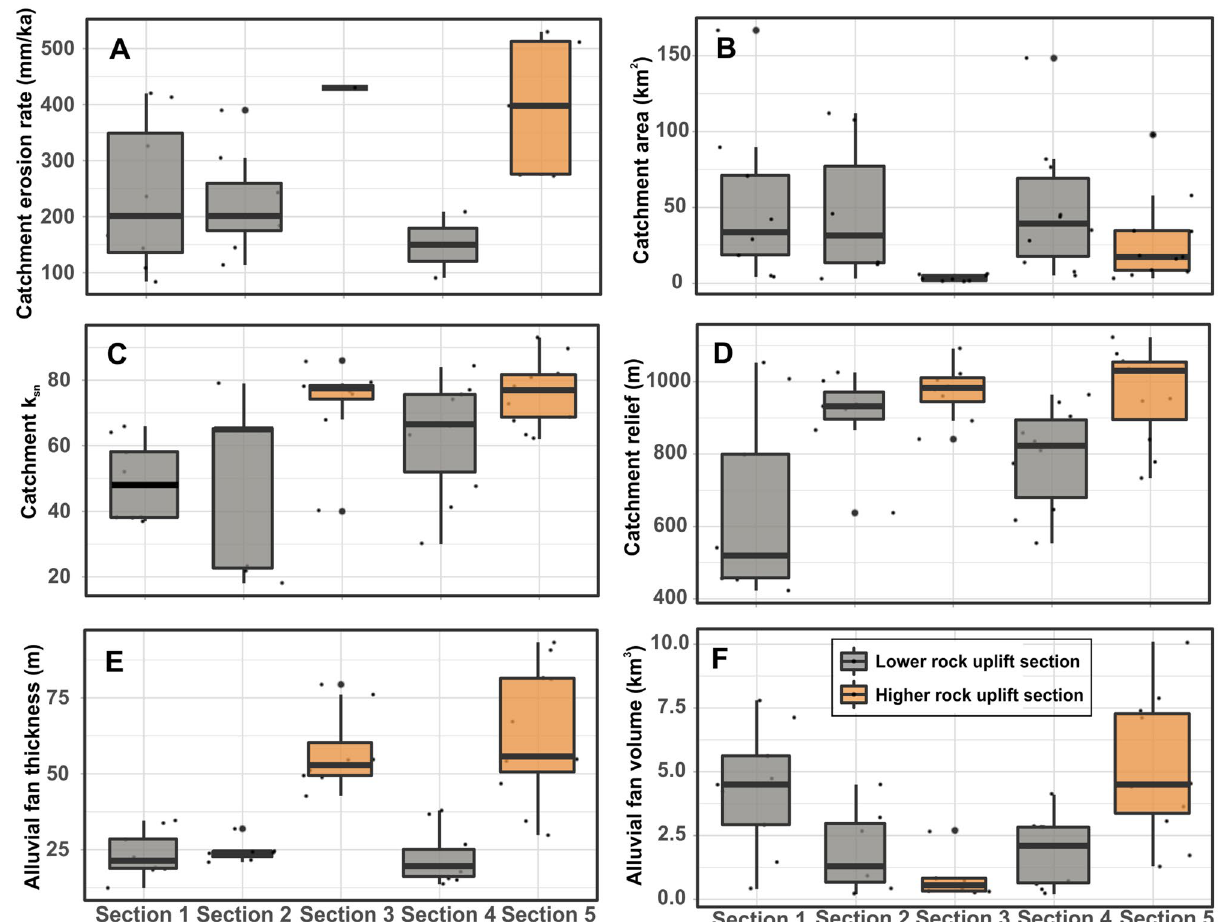
Figure 5. Boxplots showing the parameters of the alluvial fans and their catchments for each section. ( A ) Catchment-wide erosion rate, ( B ) catchment area, (C) the channel steepness index (k sn ), ( D ) catchment relief, ( E ) the fan thickness, and ( F ) fan